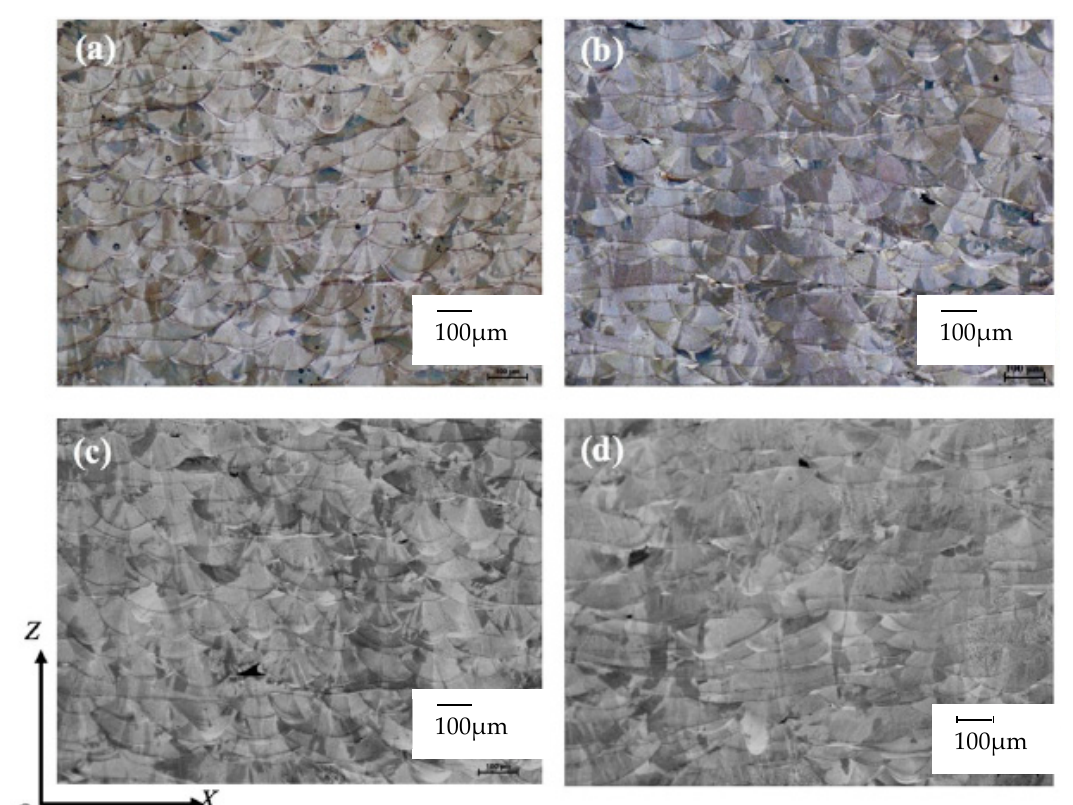
Figure 9. OM micrographs showing the microstructure of 316L samples fabricated at 200 W laser power, using different scanning strategies: ( a ) Meander; ( b ) Stripe; ( c ) Chess with 5 mm × 5 mm islands; ( d ) Chessboard with 1 mm × 1 mm islands. Z specifies the building direction [134].